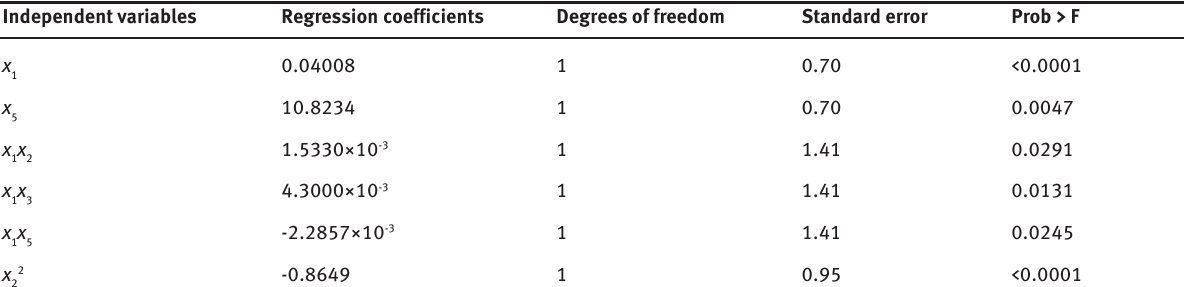
Table 1: Coded levels for five variables framed by the Central Composite Design. Independent variables